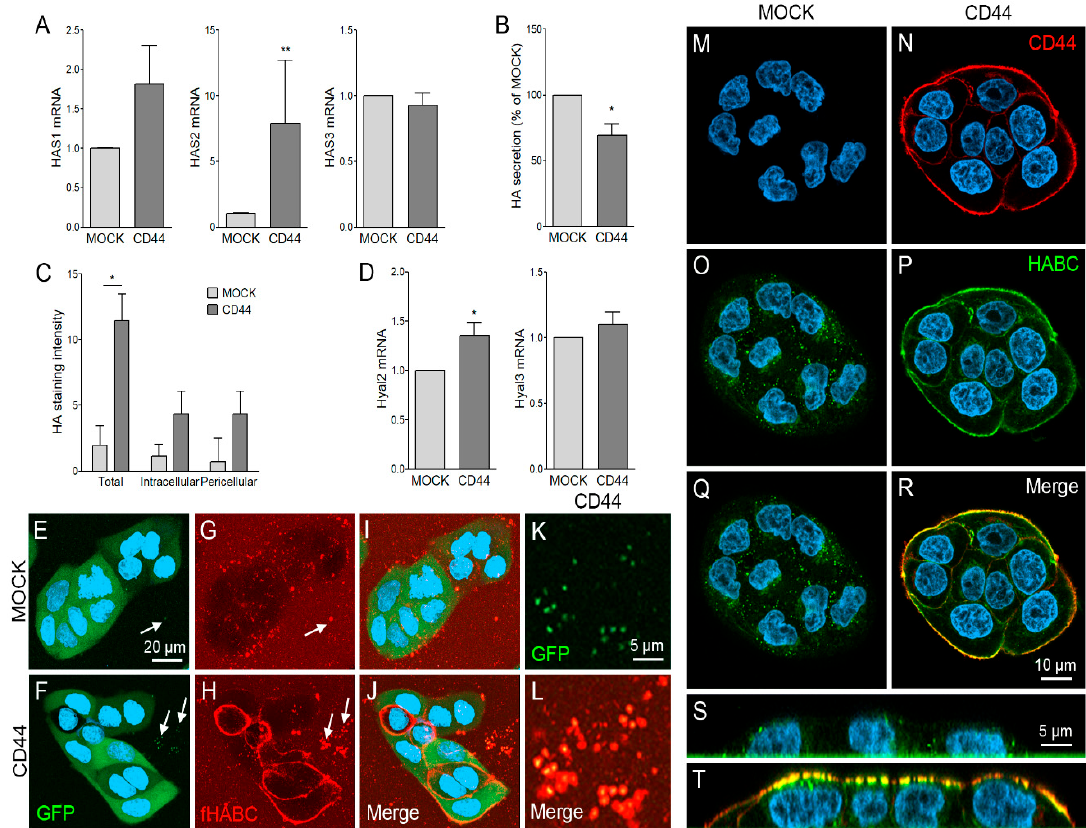
Figure 2. HA metabolism of MOCK and CD44-expressing MKN74 cells. Expression levels of HA synthases ( HAS 1-3) in MKN74 cell lines ( A ). Levels of HA secretion into culture medium ( B ) and the amount of total cell associated, intracellular and surface-associated HA measured as a mean fluorescence intensity of bHABC staining ( C ). Expression levels of hyaluronidases ( HYAL 2 and 3) are shown in ( D ). Maximum projection of confocal optical z-series of live, fHABC-stained MOCK ( E , G , I ) and CD44-positive ( F , H , J ) cells. Higher magnification of EVs secreted by CD44-expressing cells are shown in ( K , L ). Confocal optical sections of fixed, CD44 (red) and bHABC (AF633 signal pseudocolored as green) stained MOCK ( M , O , Q ) and CD44-positive ( N , P , R ) MKN74 cells. Orthogonal sections of MOCK and CD44-positive cells are shown in ( S , T ), respectively. The data in ( A , B , D ) represent means ± S.E. of 6 independent experiments. The means ± S.D. of 3 independent experiments are shown in ( C ). * p < 0.05, ** p < 0.01; Mann–Whitney test or one-sample t -test ( B